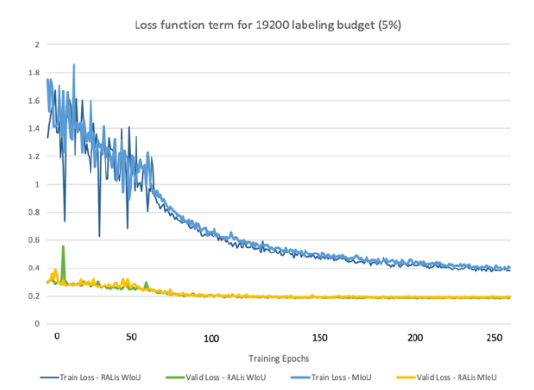
Figure 8. Training and Validation loss with 5% labeling